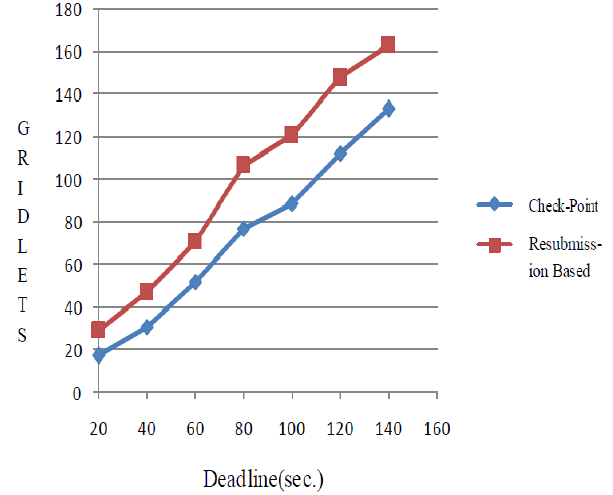
Figure 7. Number of job success for different values of the